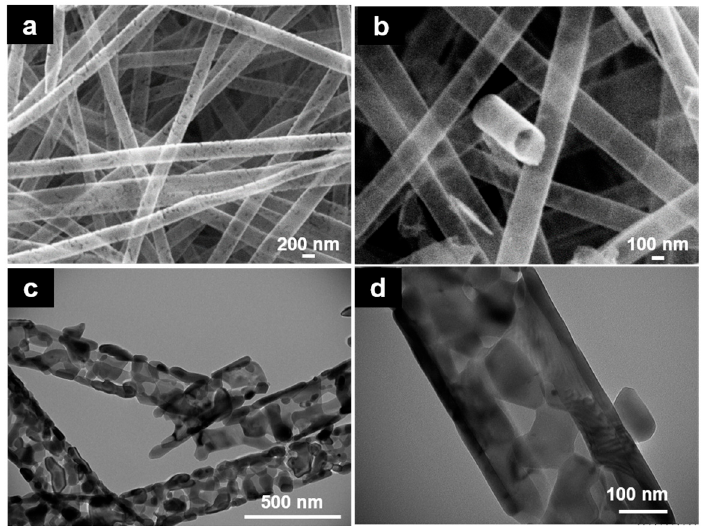
Figure 3. ( a , b ) SEM images of TDN_B600; ( c , d ) TEM images of TDN_B600 (20,000× and 60,000×, respectively).